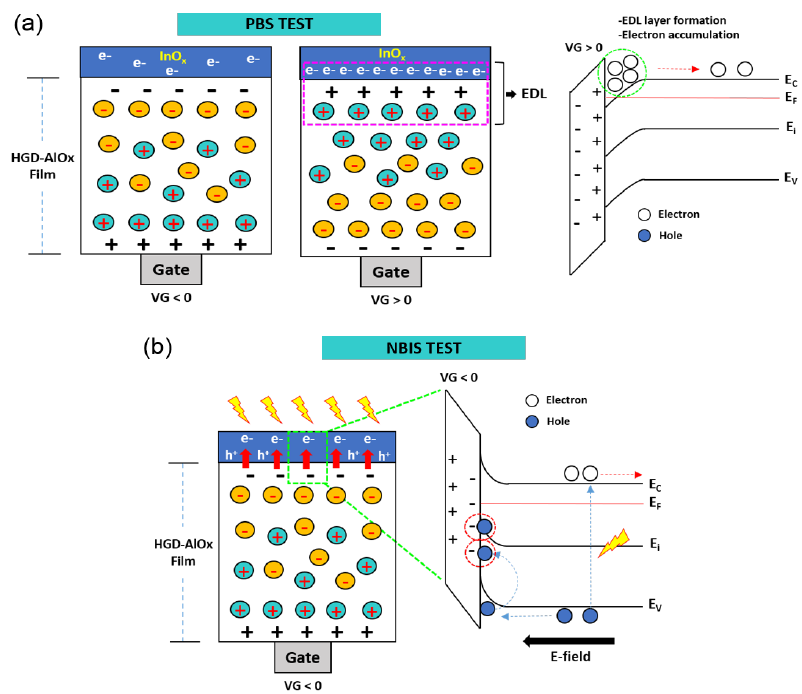
Figure 6. Schematic and energy band diagrams of corresponding V T instability of solution-processed InO x TFT with the 150 °C-annealed HGD dielectric layer for ( a ) PBS and ( b ) NBIS tests.